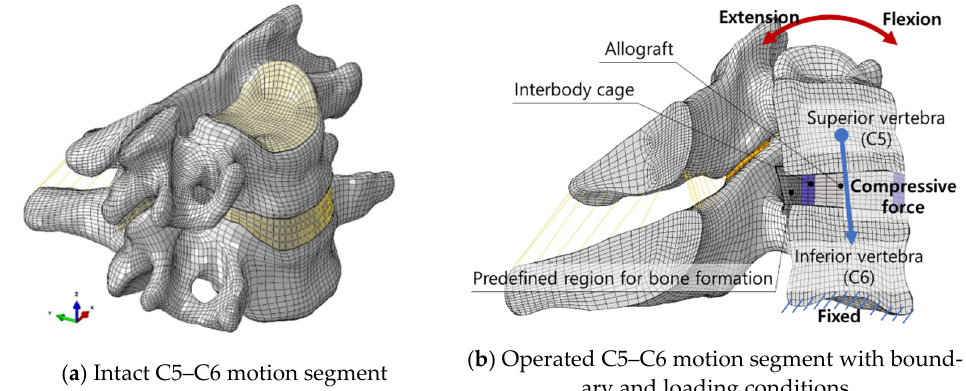
Figure 1. A validated finite element (FE) model of the C5–C6 motion segment with boundary and loading conditions.